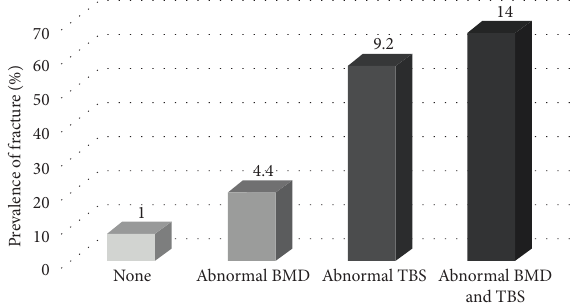
Figure 1: Prevalence of vertebral fractures predicted by the BMD and TBS. The values at the top of the bars are odds ratios